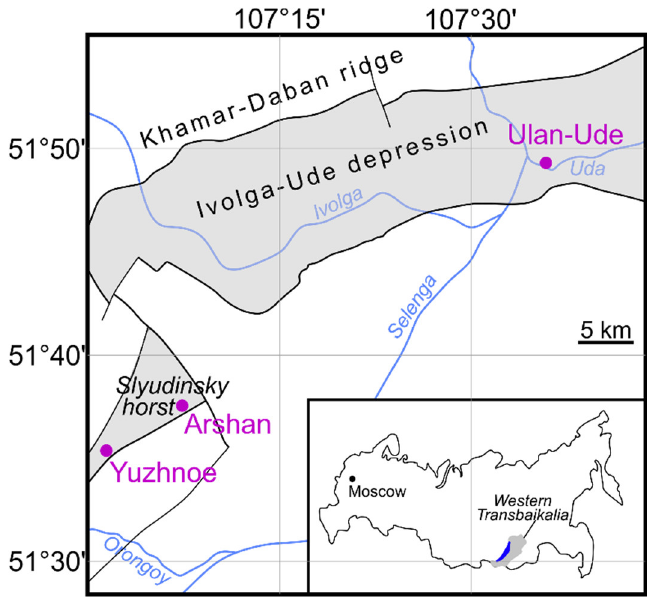
Figure 1. Tectonic position of the Arshan, Yuzhnoe, and Ulan-Ude occurrences